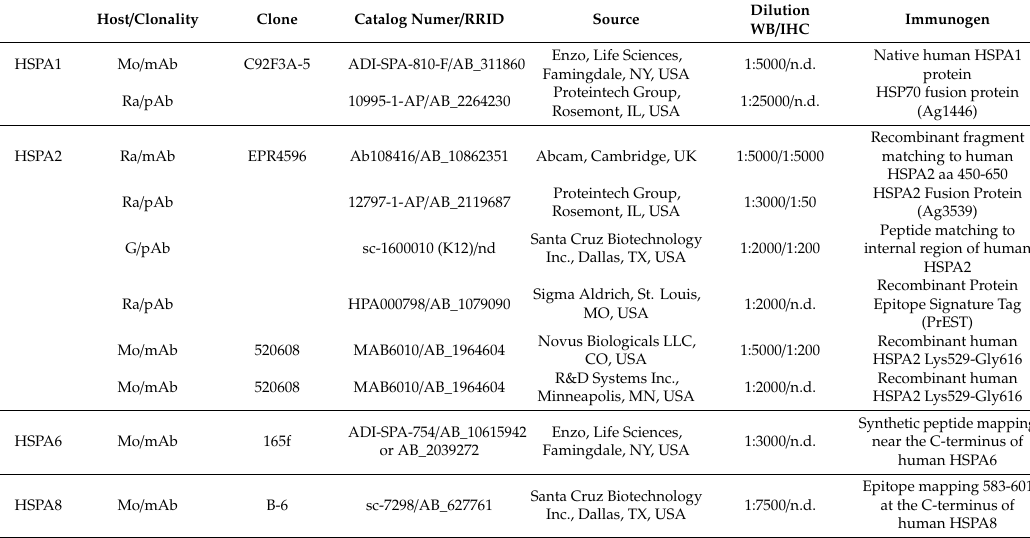
Table 3. Anti-HSPA